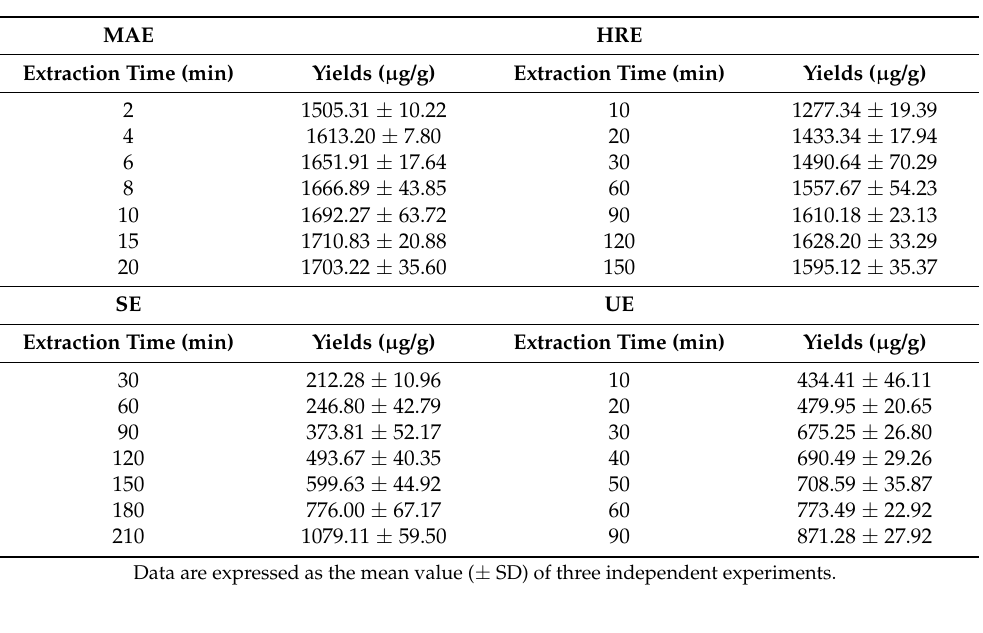
Table 1. Extraction efficiency of four processes on chickpeasaponin B1, including microwave-assisted extraction (MAE), heat reflux extraction (HRE), Soxhlet extraction (SE), and ultrasonic extraction (UE).